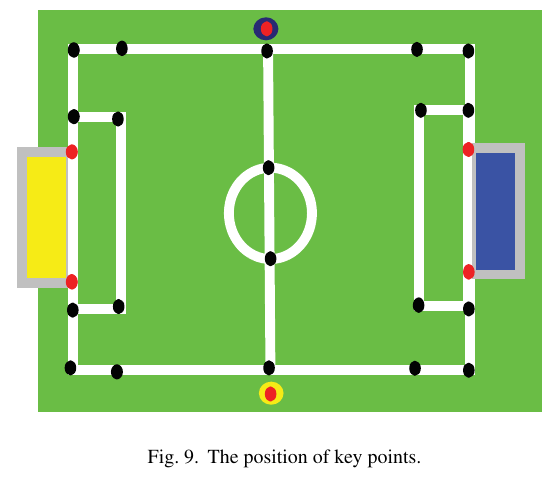
Fig. 9. The position of key points.